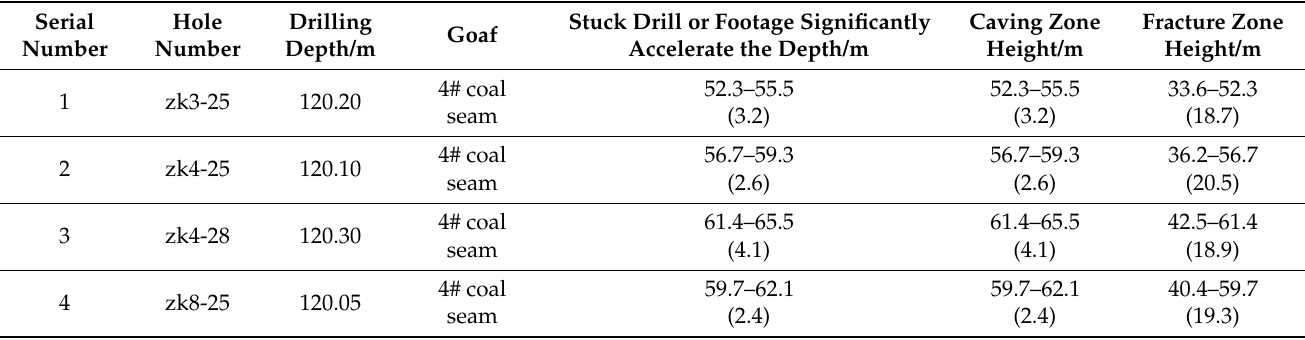
Table 4. List of the “three zones” in the 4# coal seam goaf.